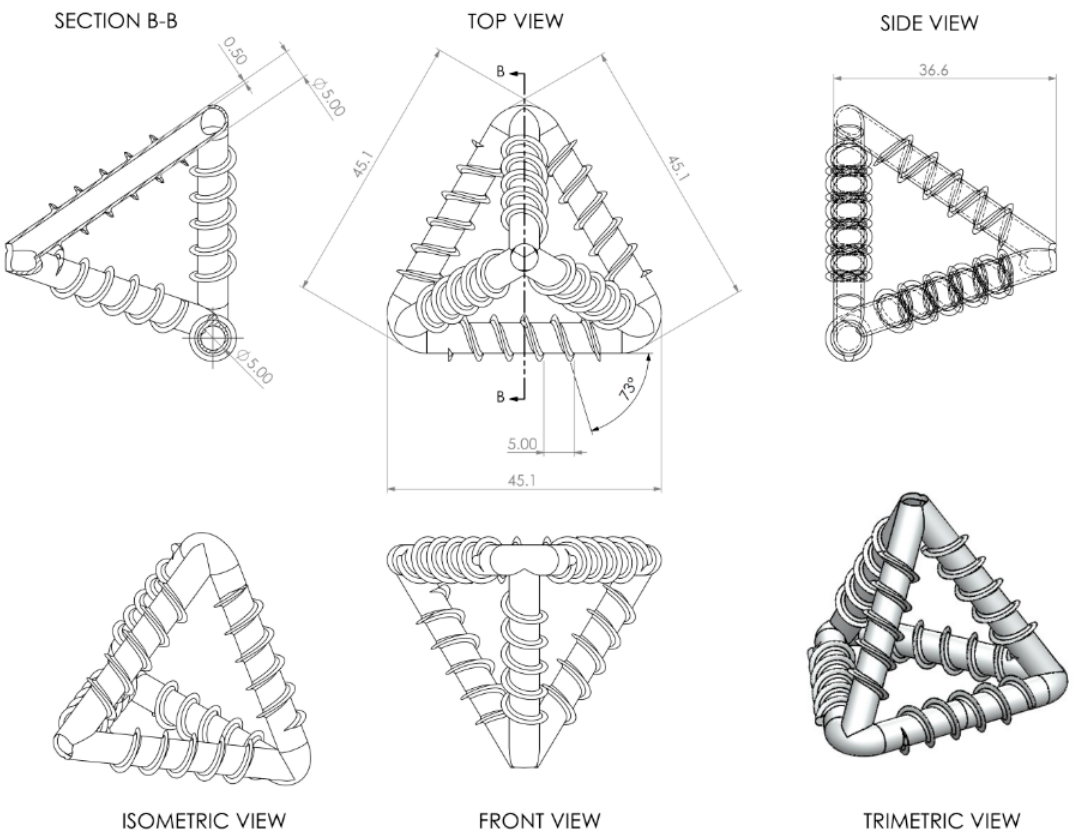
Figure 2. Dimensions of a TET unit (dimensions in mm).